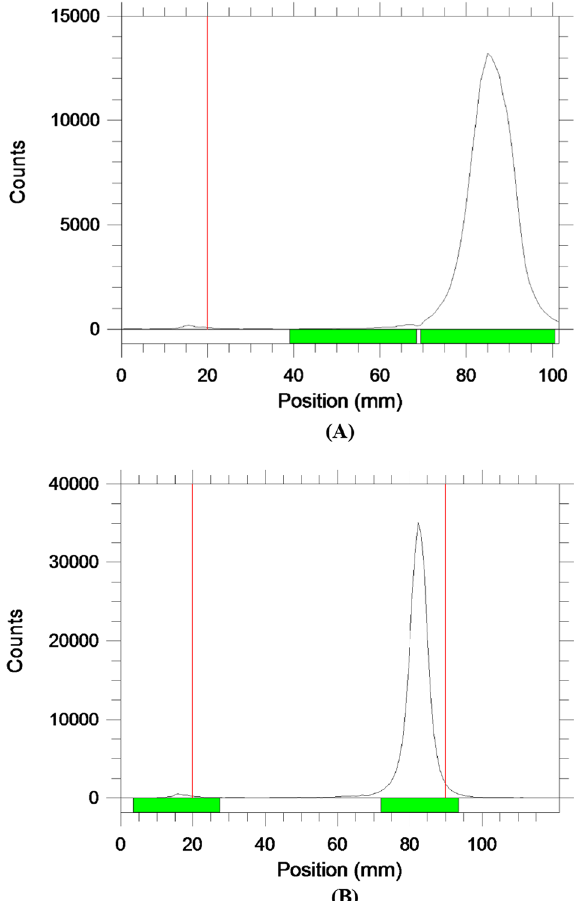
Fig. 2 TLC chromatograms of ( A ) 64 Cu-NOTA- and ( B ) 64 Cu-NOTAM rhodamine conjugates. In the TLC chromatograms, the free copper remained at the origin (R f : 0–0.15) while the radiolabeled. 64 Cu-complexes moved to R f values of